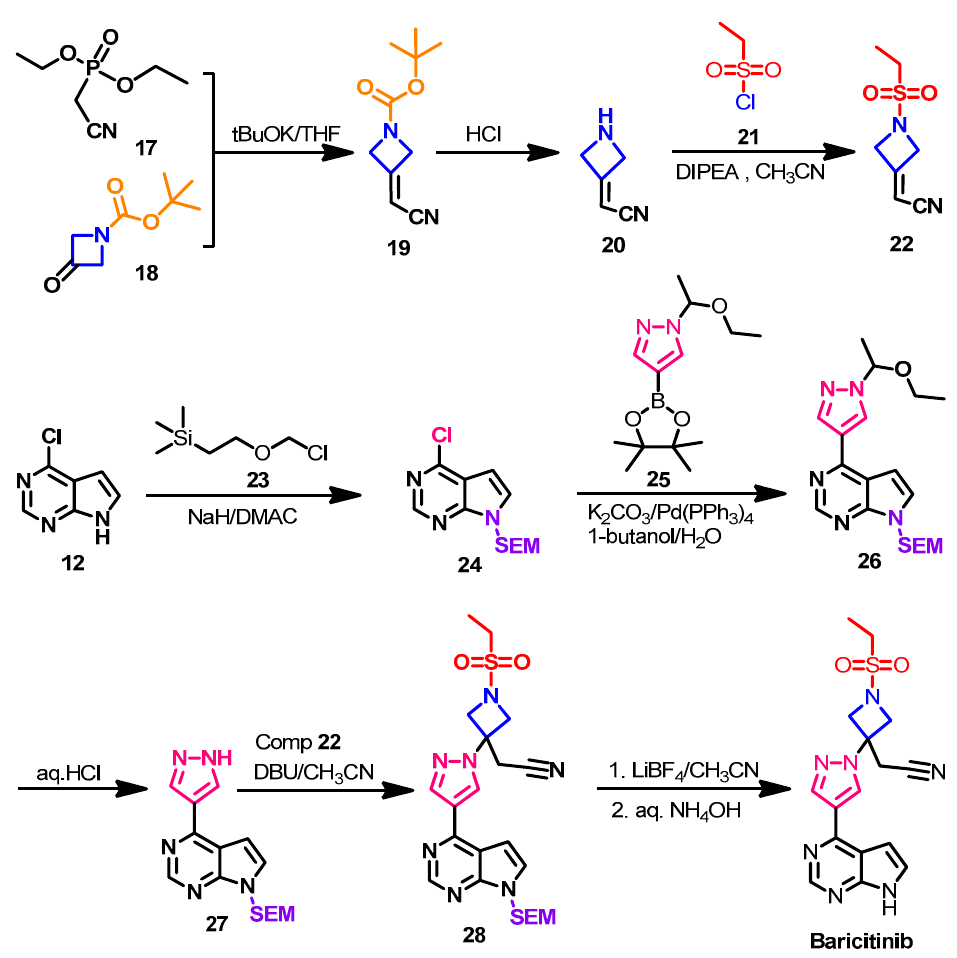
Figure 16. Chemical structure/name/synonyms of baricitinib.